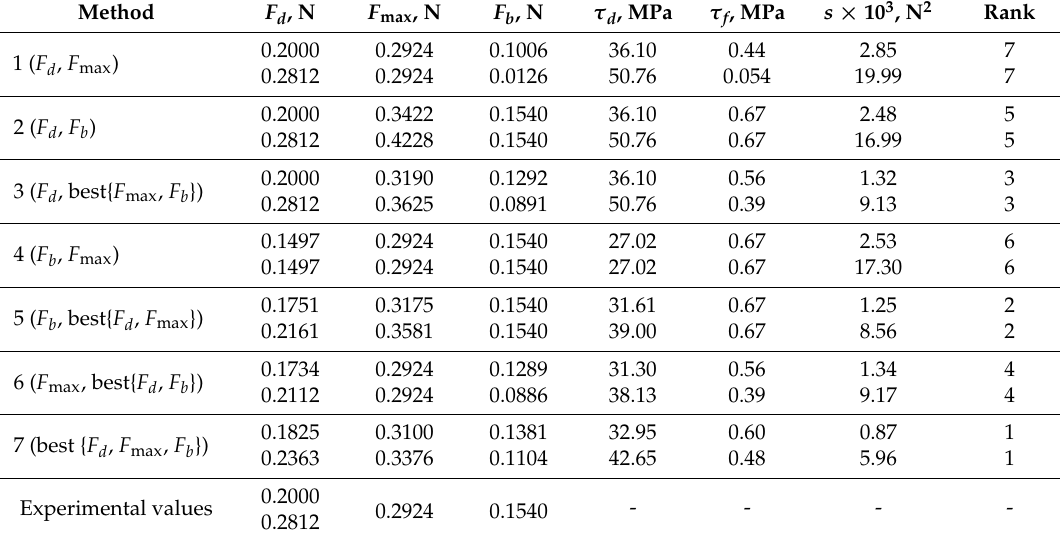
Table 5. Interfacial strength parameters determined from the experimental force–displacement curve for PVA fiber–concrete matrix pair using different methods.